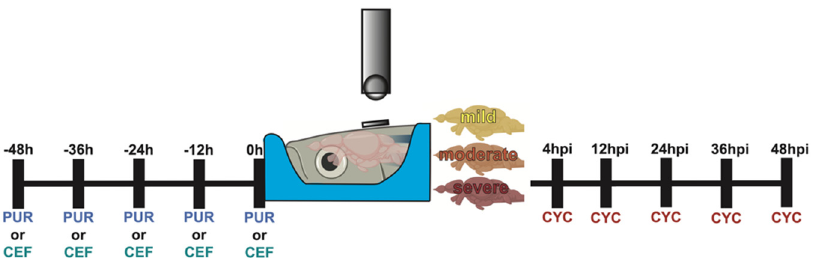
Figure 1. Experimental timeline of Shh modulation. Graphical representation of the dosing schedule of purmorphamine, ceftriaxone, and cyclopamine in relation to the timing of the